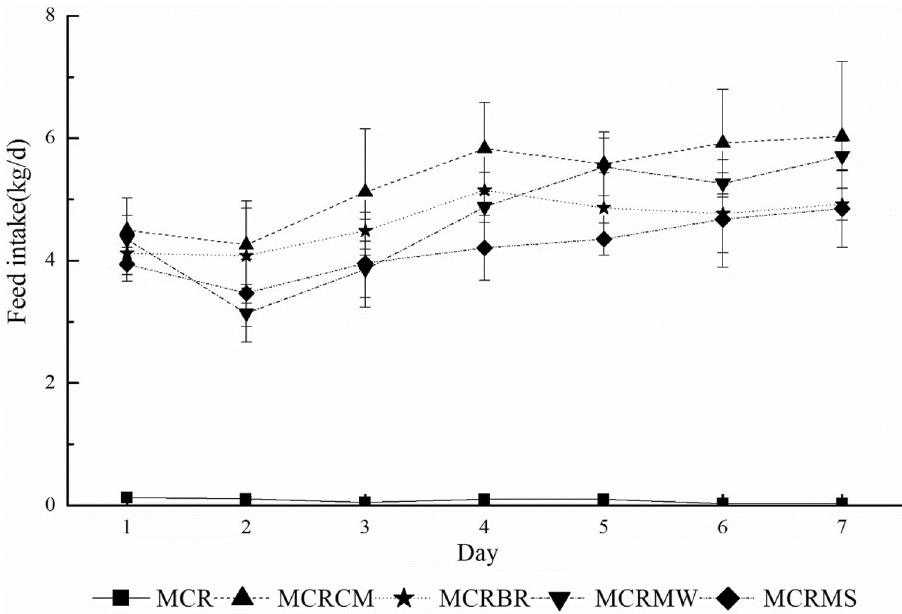
Figure 1. Mean intake of treated marigold crop residue (MCR) by cattle during a 30-min interval for seven consecutive